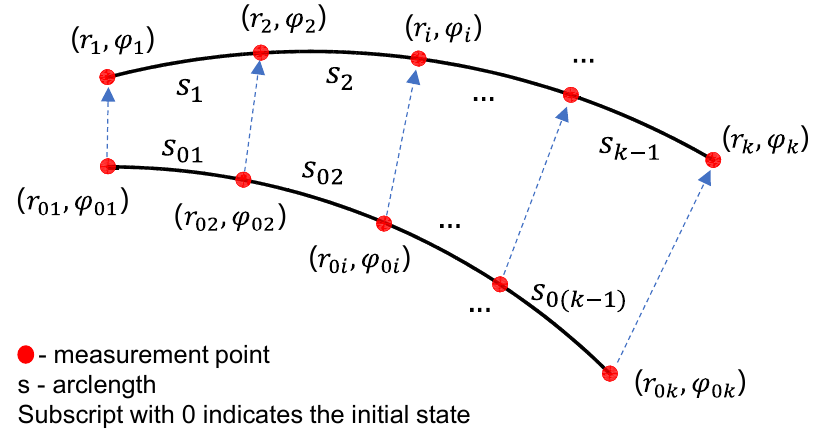
Figure A1. The nomenclature of Equation (A1).